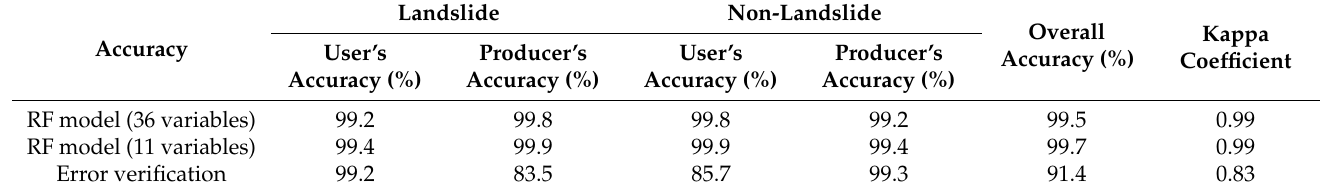
Table 3. Results of RF model accuracy evaluation and error verification of the predicted landslide map.